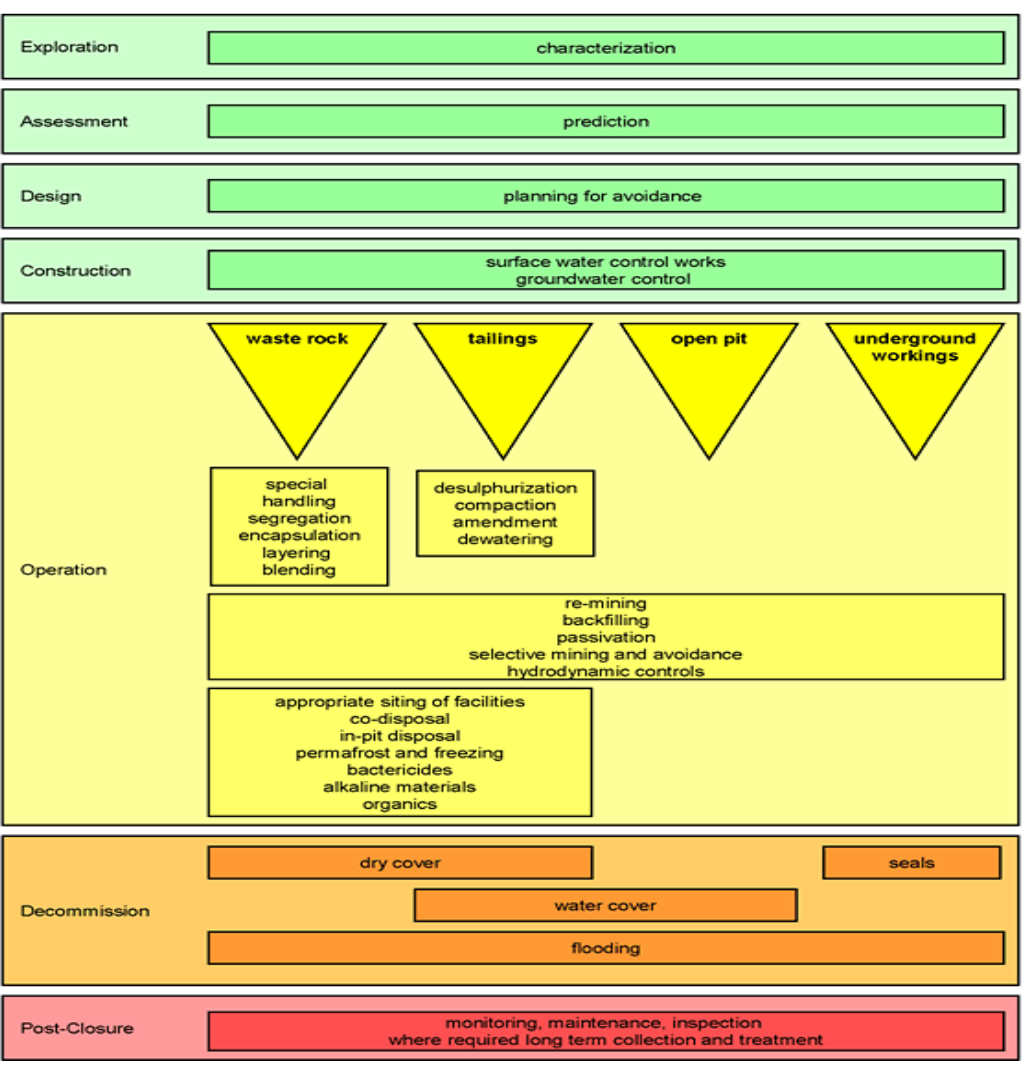
Figure 2. Methods for Prevention and Mitigation of acid rock drainage (ARD)